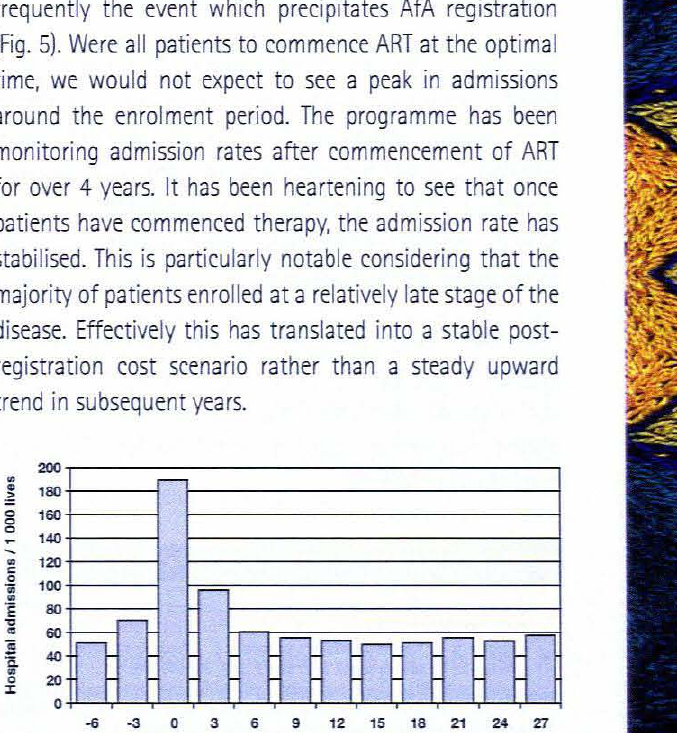
Fig. 4. Viro/ogicol response to ontiretroviral therapy in Aid for AIDS